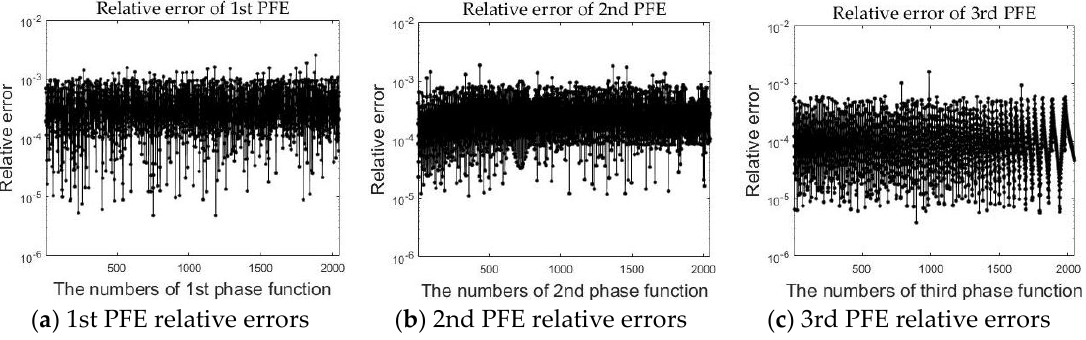
Figure 5. The relative errors between hardware and software computation.